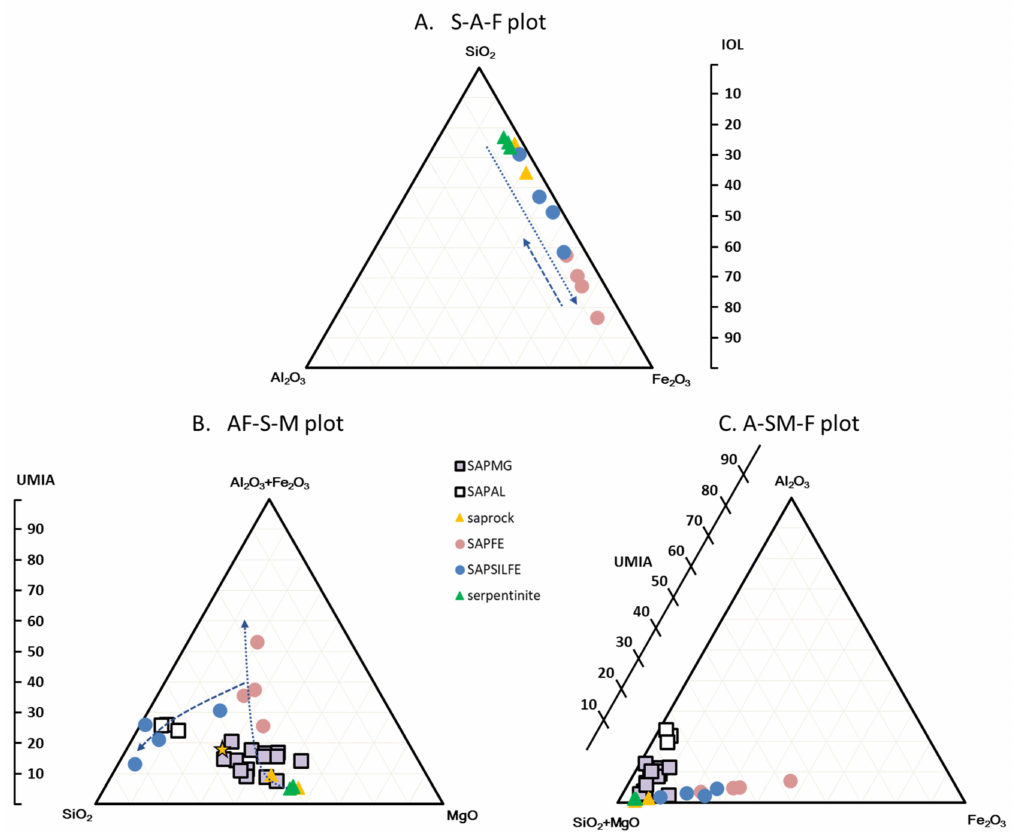
Figure 20. ( A ) Wt% SiO 2 -Al 2 O 3 -Fe 2 O 3 (SAF) ternary plot showing the alteration trend during laterisation of the dunite protolith (dotted arrow) and the subsequent impact of late stage silicification (dashed arrow). ( B , C ) Molar ternary plots in UMIA space (SiO 2 -MgO-Fe 2 O 3 -Al 2 O 3 ) showing the weathering trends of the dunite and troctolitic intercalations. ( B ) Highlighting the changed trend due to silicification of the SAPFE unit. Gold star represents average troctolite composition from [27]. ( C ) The bauxitisation trend associated with the formation of SAPMG and SAPAL compared to the laterisation process of the saprock SAPFE and SAPSILFE